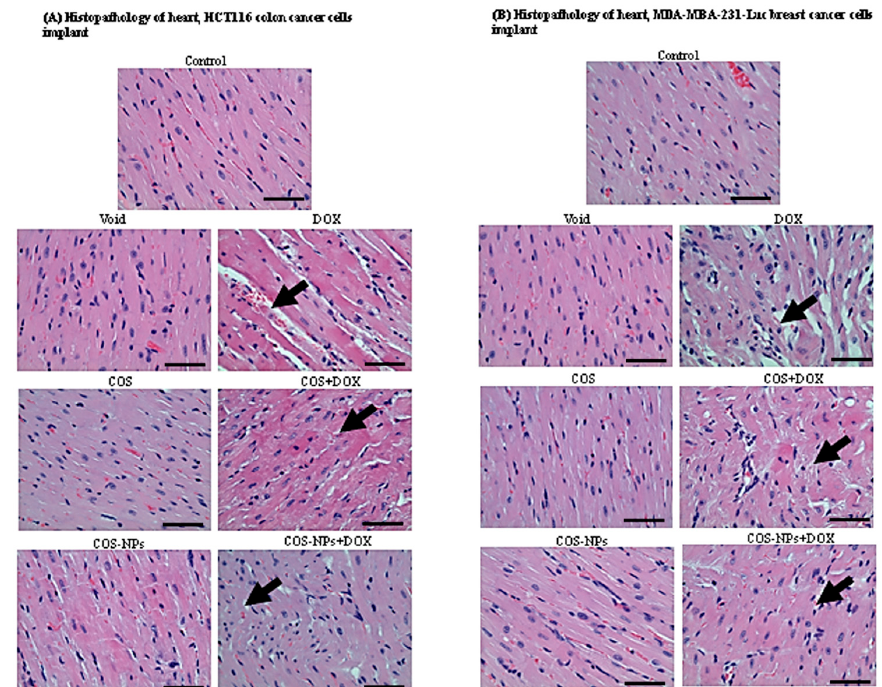
Figure 9. Histopathological assessment of heart sections in ( A ) HCT116 colon cancer cells implant and ( B ) MDA-MB-231-Luc breast cancer cells implant treated with costunolide (COS), doxorubicin (DOX), costunolide + doxorubicin (COS+DOX), costunolide-nanoparticles (COS-NPs), and costunolide-nanoparticles + doxorubicin (COS-NPs+DOX). Black arrows refer to cellular damages of doxorubicin (DOX). Scale bar shows magnification 40 × .